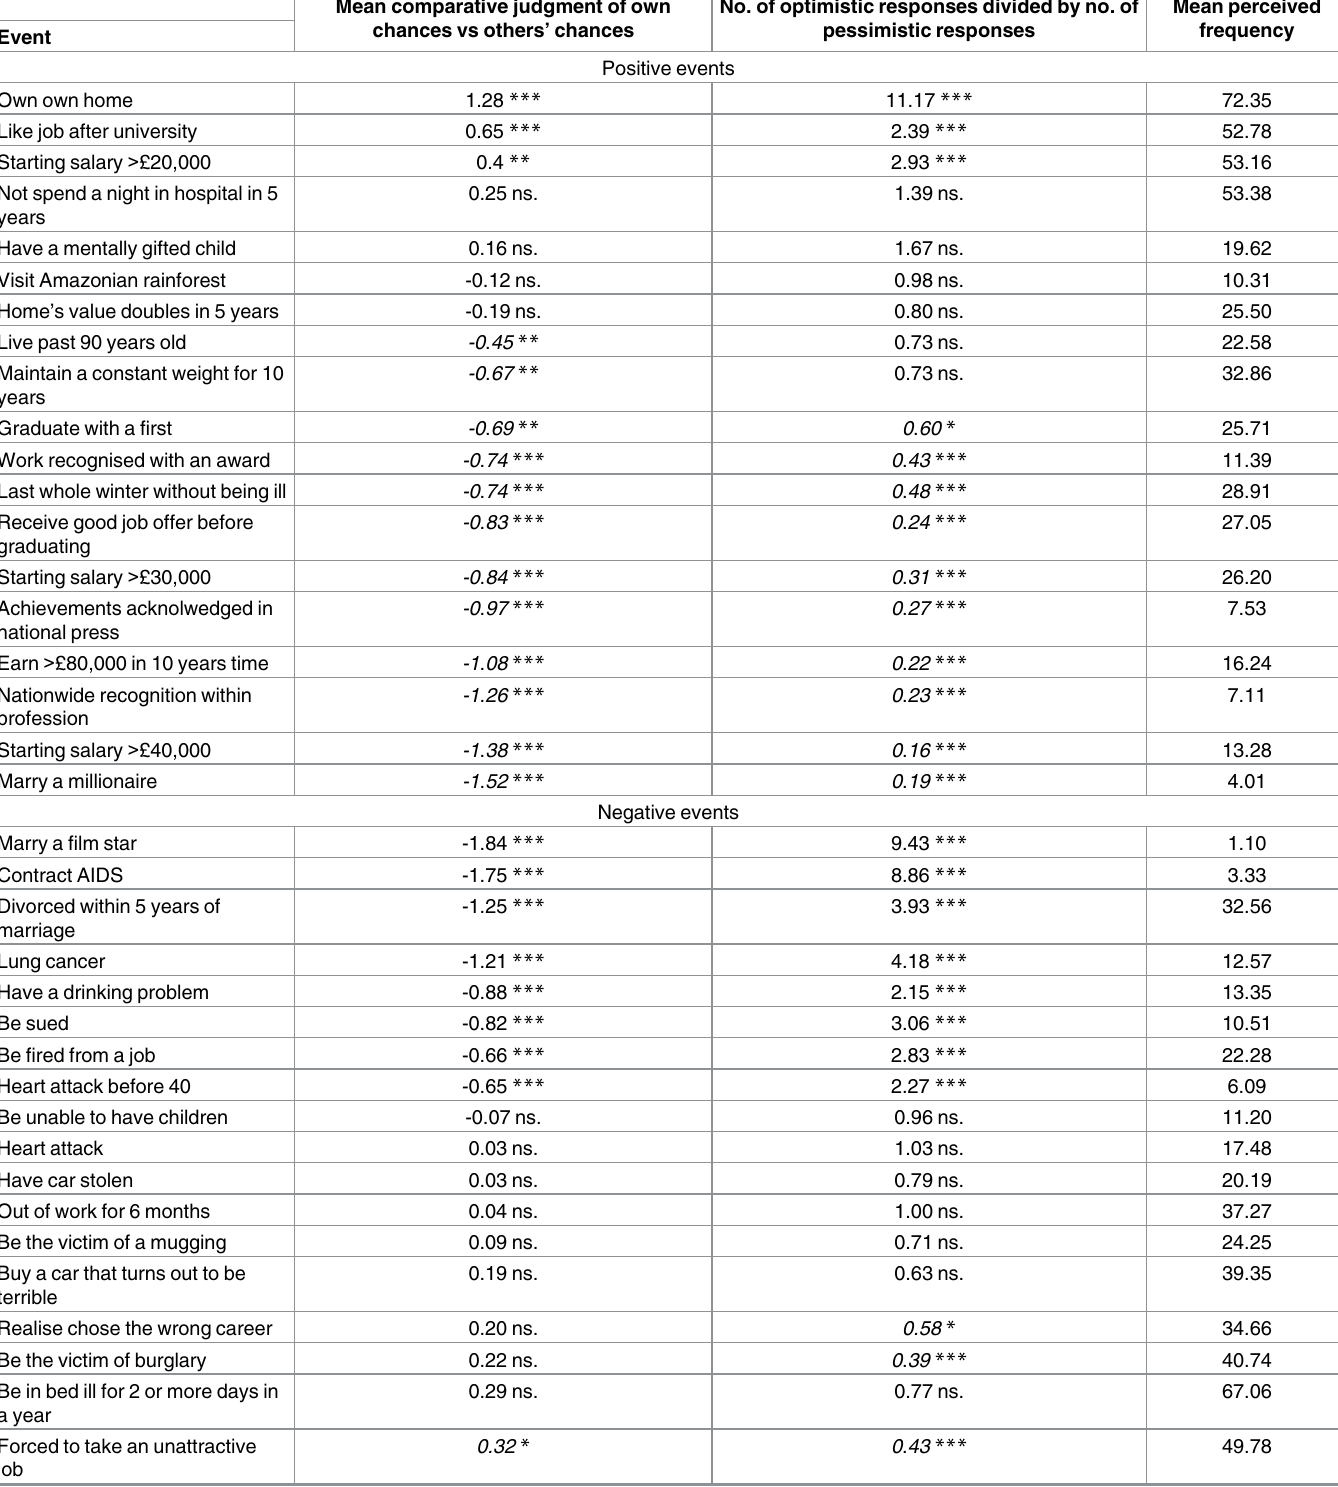
Table 1. ‘Unrealistic optimism’ for future life events. Mean comparative judgment of own chances vs others’